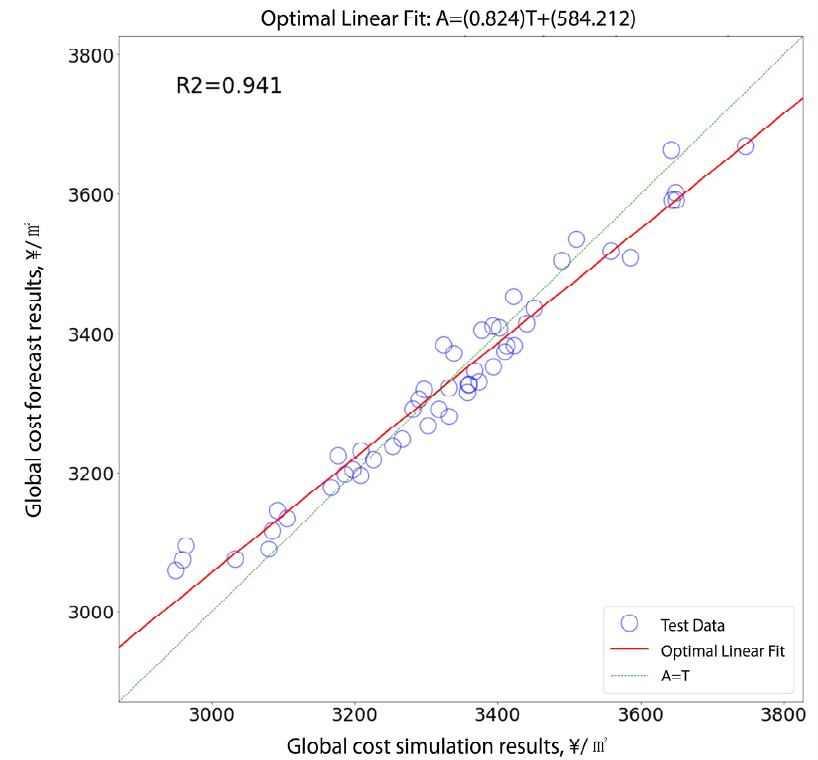
Figure 18. Prediction model of indoor thermal environmental comfort.